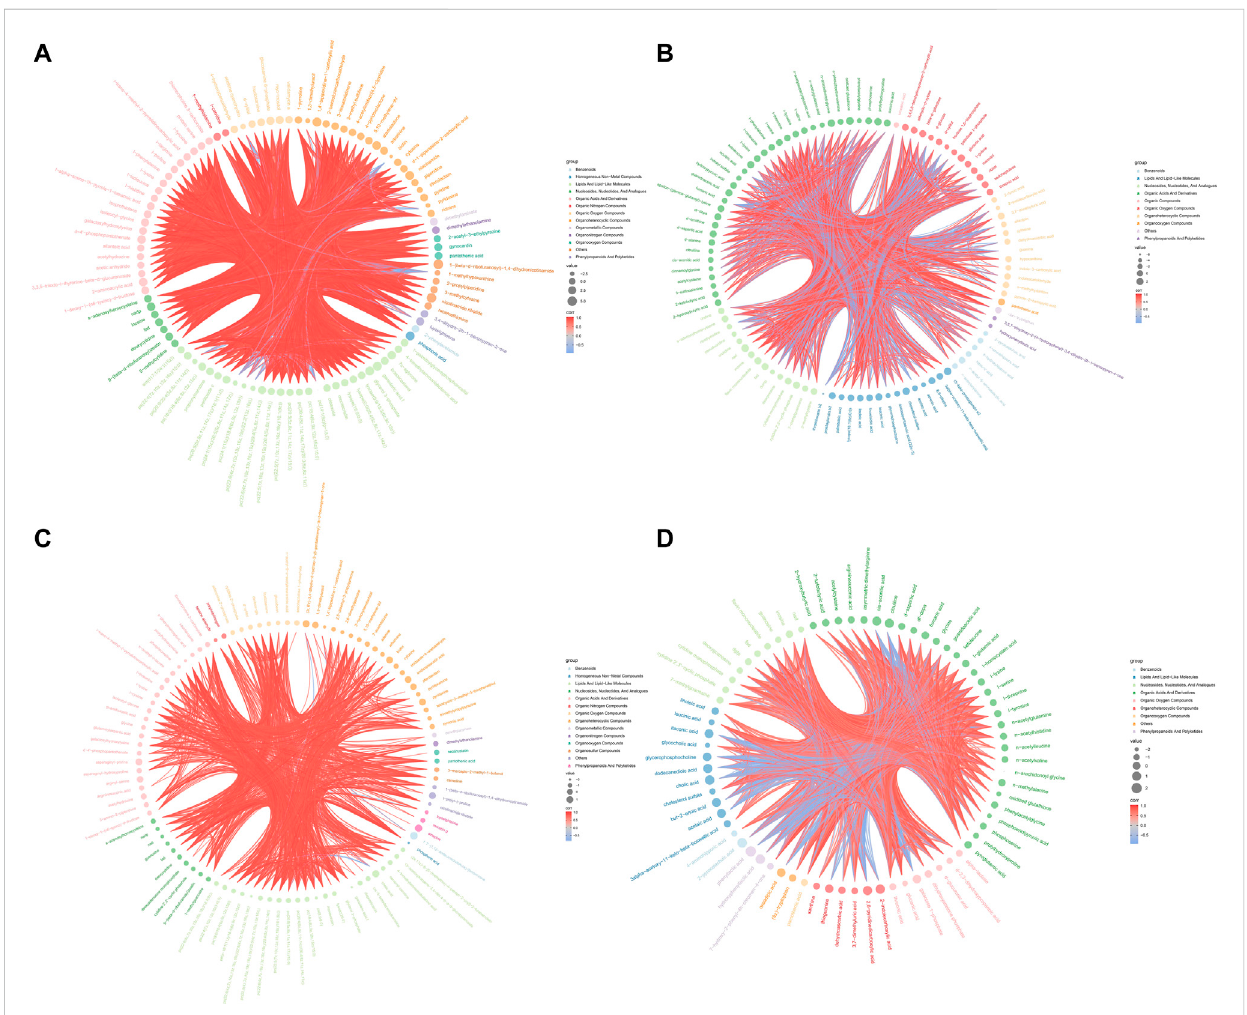
FIGURE 7 Chord diagram of spearman correlation analysis N versus M in positive (A) and negative (B) ion mode. Chord diagram of spearman correlation analysis the M versus AMCZ in positive (C) and negative (D) ion